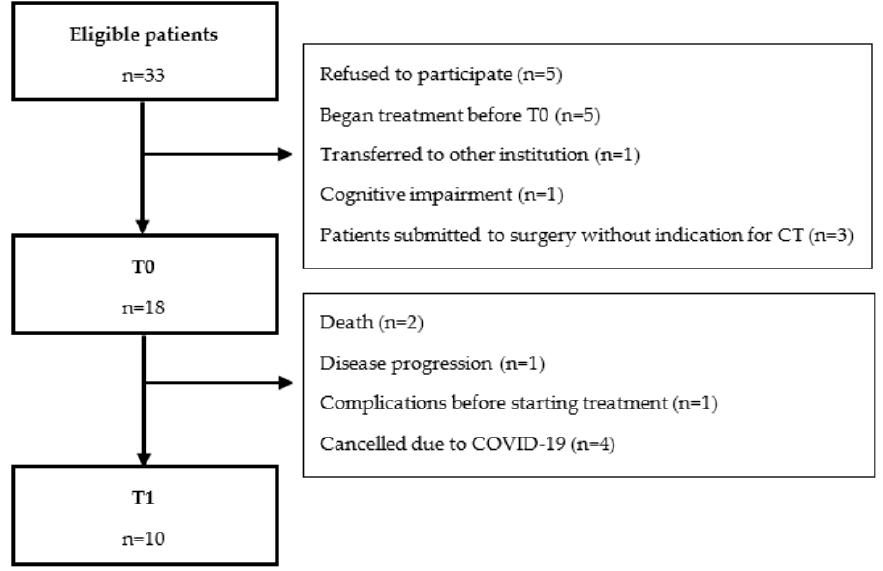
Figure 1. Consort Figure 1. Consort diagram.